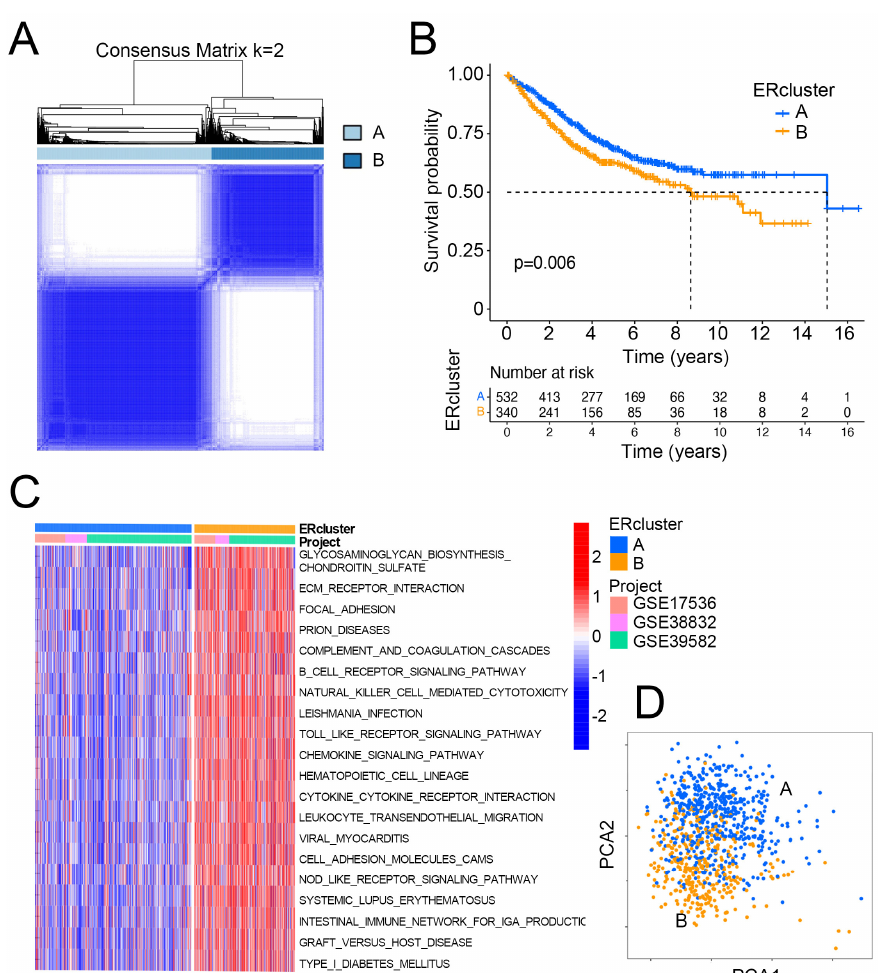
Figure 2. ER stress-related sub-clusters of CRC. ( A ) Consensus clustering defines two (k = 2) clusters named as ERcluster A ( n = 532) and ERcluster B ( n = 340) in patients with CRC (GSE17536, GSE38832, GSE39582) based on ER stress-related gene sets. ( B ) Kaplan–Meier survival analysis of the ERcluster A and B (log rank test p value = 0.006), x axis indicates the number of years after initial diagnosis of CRC. ( C ) GSVA analysis of pathways in the two sub-clusters, red and blue represent the upregulated and downregulated pathways in each sample, respectively. ( D ) PCA analysis illustrates a distinct difference of transcription profile between the two